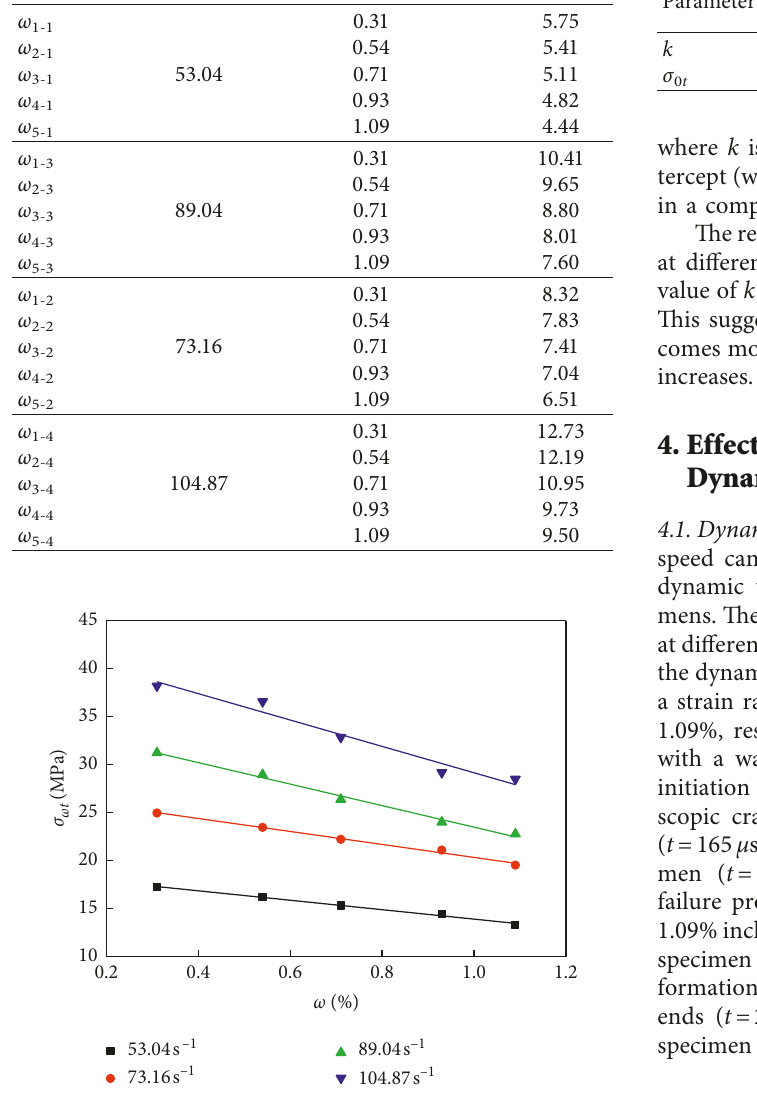
Figure 5: Change of the tensile strength against the water content.